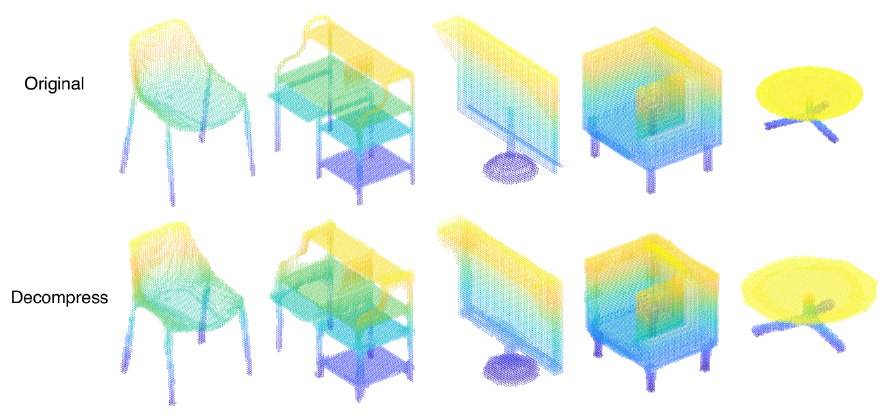
Figure 12. Results from different point clouds.